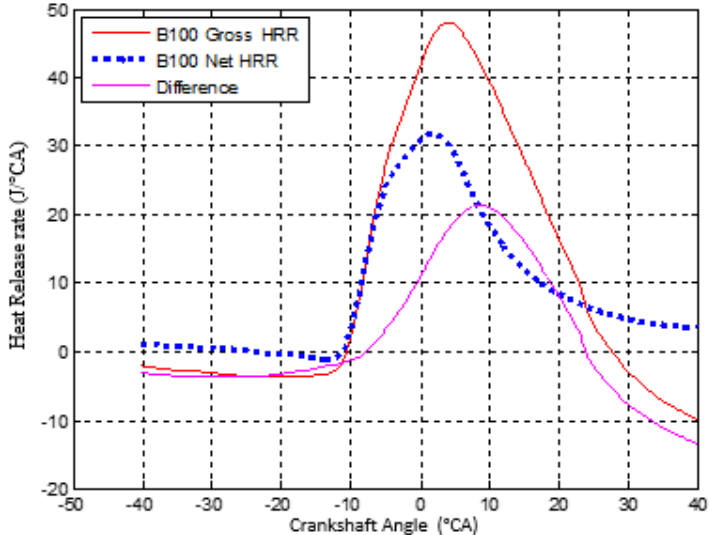
Figure 10. Profile of net heat release rate (Net HRR) evolution and gross heat release rate (Gross HRR) for engine speed n = 1500 rpm at 100% load according to B100 combustion.